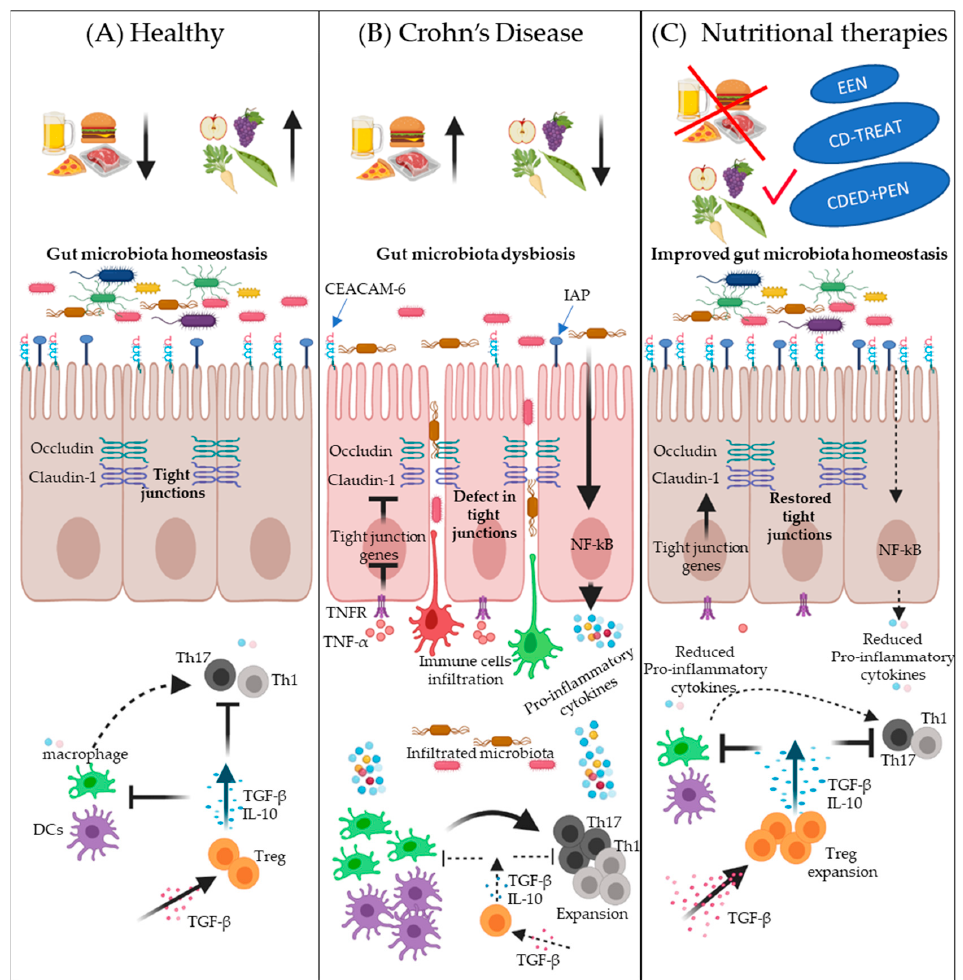
Figure 1. Schematic overview of some potential mechanisms of nutritional-therapy-induced remission in Crohn’s disease (CD). Panel ( A ) depicts the intestinal homeostasis in health associated with a healthy diet, i.e., less intake of a Westernized diet (normal microbiota diversity, normal expression of IAP and CEACAM-6, less interactions between bacteria and epithelial cells, normal expression of tight junction proteins such as occludin and claudin-1, less penetration of epithelium by potentially pathogenic bacteria and infiltration of immune cells, better immune surveillance by Tregs, and normal expression of TGF- β ). Panel ( B ) illustrates the potential effects of a Westernized diet on the development of CD: low expression of antigen-related cell adhesion molecule (CEACAM-6) and intestinal alkaline phosphatase (IAP), decreased tight junction proteins expression, defects in intestinal barrier function, increased bacterial adherence to epithelial cells, stimulation of epithelial cells to express proinflammatory cytokines, increased bacterial and immune cells infiltration, reduced TGF- β , decreased Treg cells expansion, increased expansion of proinflammatory T-cells, and elevated proinflammatory cytokines expression by immune cells. Panel ( C ) describes the potential of nutritional therapies to correct dysbiosis and to reduce intestinal inflammation. Nutritional therapies can enhance microbial diversity and increase the expression of CEACAM-6 and IAP to prevent the adherence of bacteria with epithelial cells. Nutritional therapies can also reduce proinflammatory- cytokine-induced barrier dysfunction, such as TNF- α , thus normalizing the expression of tight junction proteins and improving intestinal barrier function, which, in turn, leads to less infiltration of microbes and immune cells. TGF- β supplementation has a beneficial effect on T-cell polarization into a Treg phenotype, which inhibits T-cell polarization into Th1 and Th17 subsets as well as dampening inflammatory macrophage function.